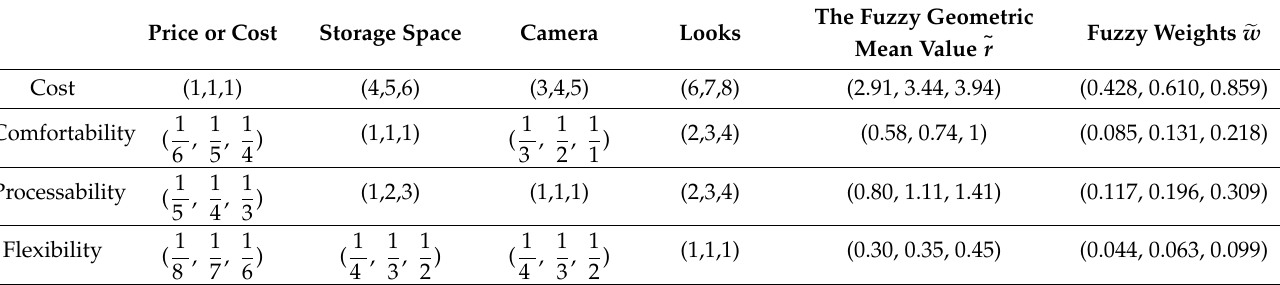
Table 7. Fuzzified pairwise comparison matrix.